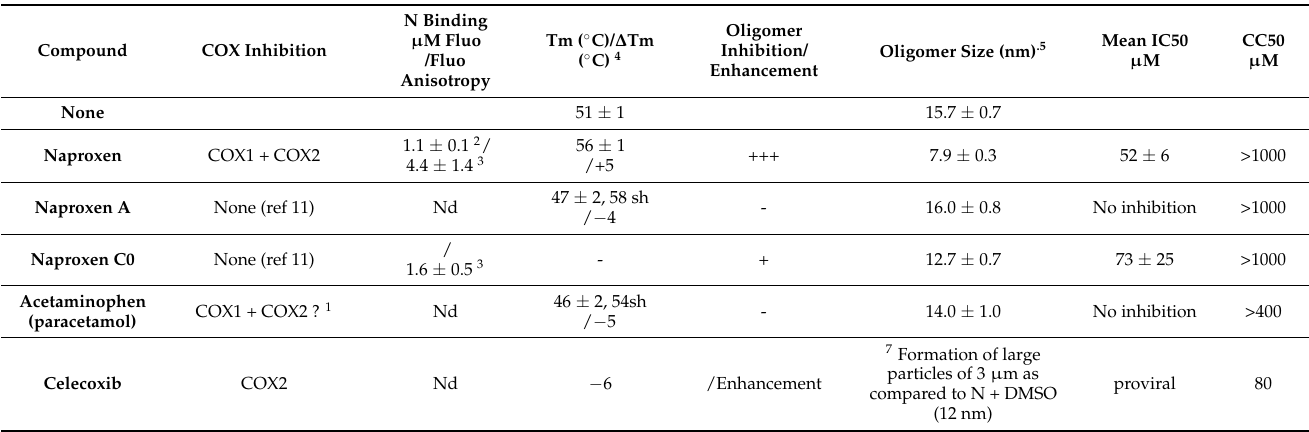
Table 2. Summary of the compounds, their COX inhibition, and their ability to bind to N NTD, to modify NTD oligomeriza- tion induced by nucleic acid binding and their antiviral